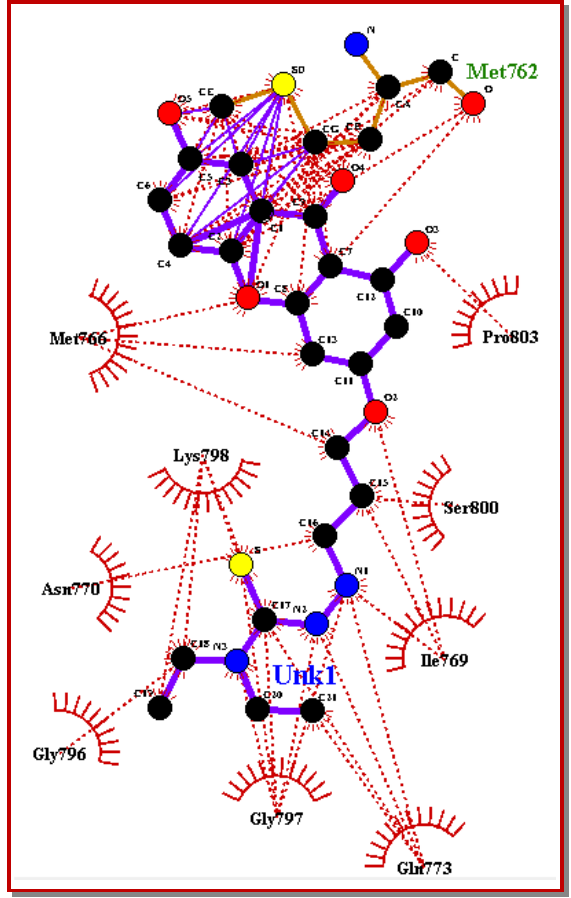
Figure 4: Hydrophobic and hydrogen bond forming residues of the docked complex of XM7 and the model. Hydrophobic interactions are shown in red dotted line and hydrogen bonds are shown in green dotted